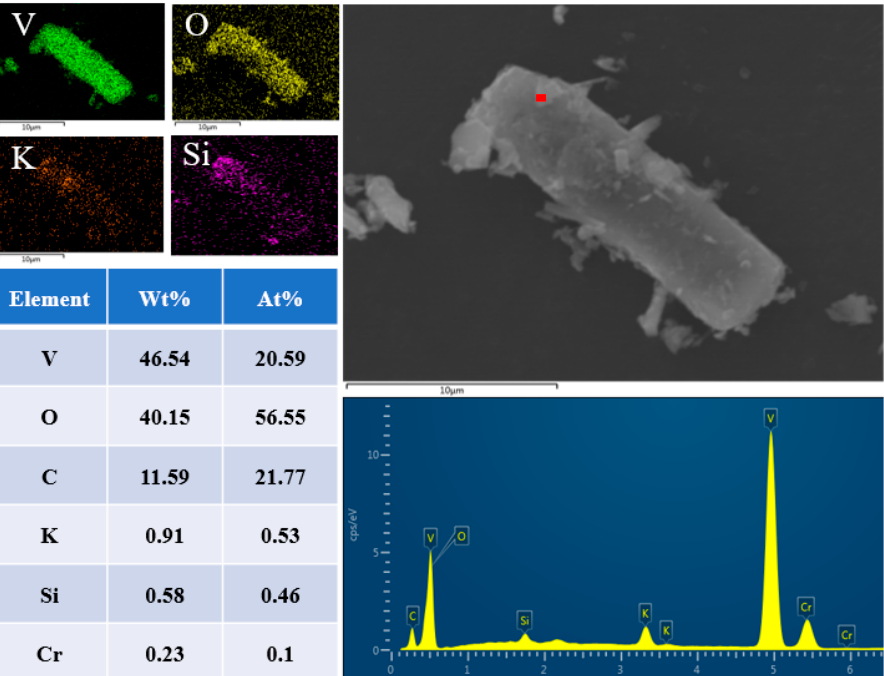
Figure 12. SEM-EDS characterization of the V 2 O 5 product.